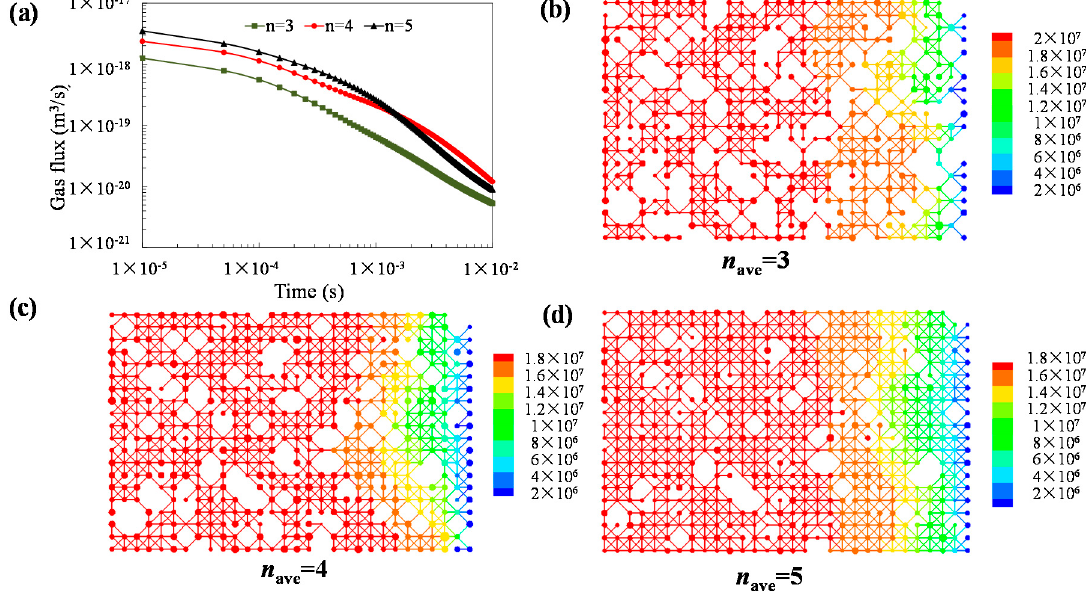
Figure 9. Impact of pore structure connectivity on gas flow in shale matrix: ( a ) gas flux variation; ( b ) pressure contour n ave = 3; ( c ) pressure contour n ave = 4; and ( d ) pressure contour n ave = 5.